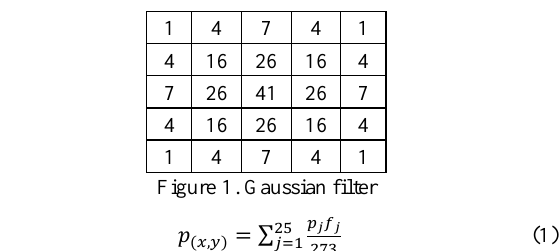
Figure 1. Gaussian filter